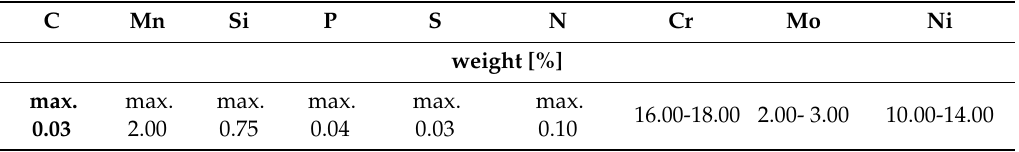
Figure 4. SEM images of 316L powder grains captured at scales of ( a ) 50 µm and ( b ) 10 µm. The chemical composition of the material is listed in Table 1. Table 1. Chemical composition of 316L austenitic